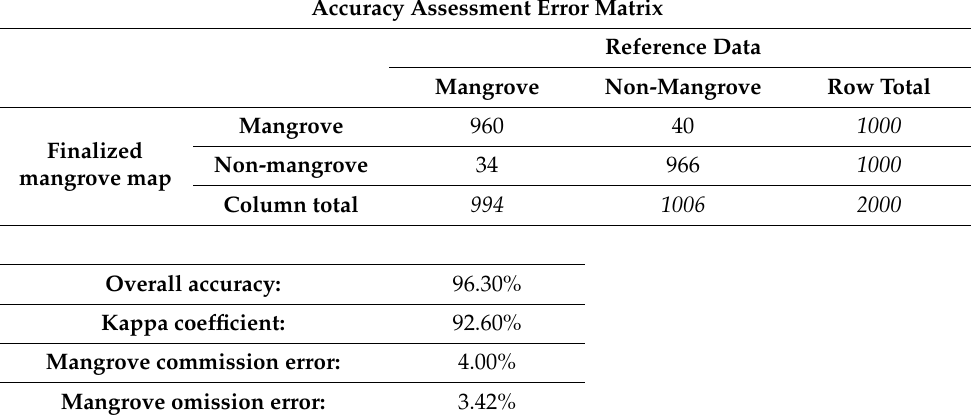
Table 1. Summary of accuracy assessment